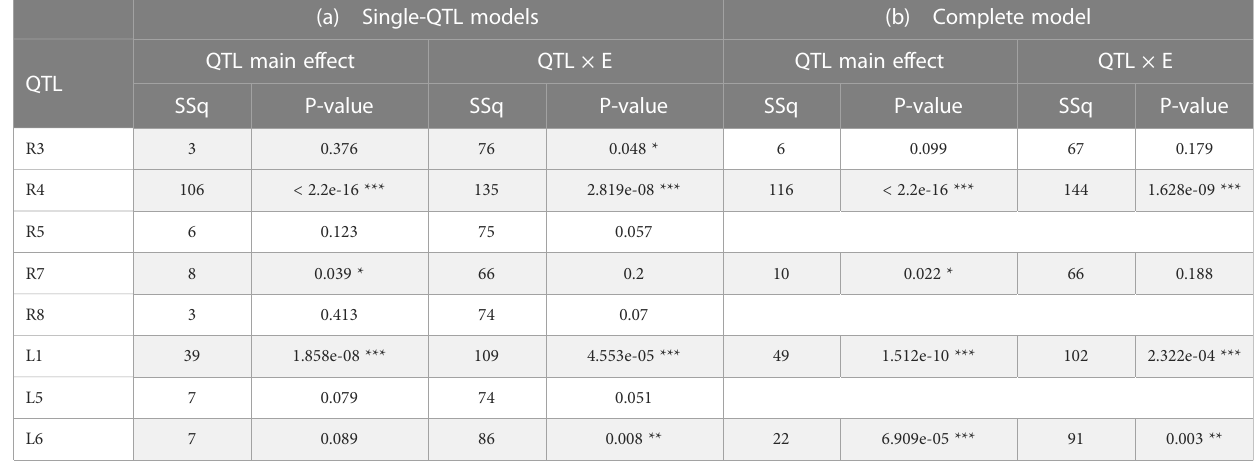
TABLE 3 Wald tests for fi xed effects of single-QTL models and the complete model, for beginning of fl owering